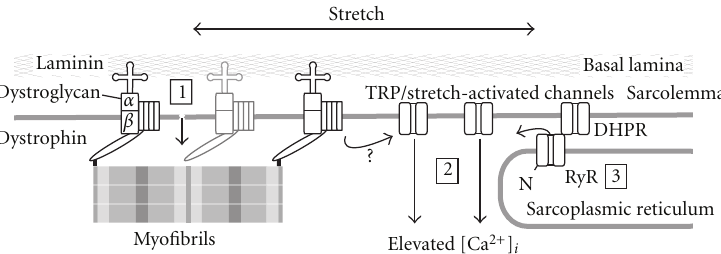
Figure 1: Sources of calcium entry in dystrophic muscle. (1) Disruptions to the DGC can result in instability of the sarcolemma that permits calcium entry through membrane tears when the sarcolemma is stretched during lengthening muscle contractions. (2) Activity of calcium leak, stretch-activated, and various TRP channels has been shown to be increased in dystrophin-deficient muscle and their inhibition in vivo can improve dystrophic pathology. (3) The ryanodine receptor has recently been shown to be hypernitrosylated in mdx muscle which may result in an increased leak of calcium from the sarcoplasmic